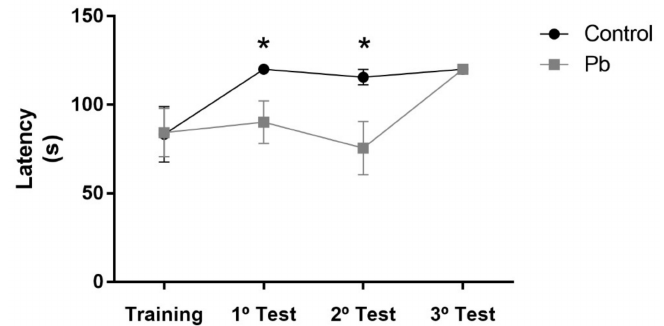
Figure 3. E ff ect of long-term exposure of young Wistar rats to 50 mg / Kg of Pb on locomotion activity in the Rotarod test. The results are expressed as mean ± standard error. * Lead vs. Control on di ff erent times ( one-way ANOVA with repeated measures , p <